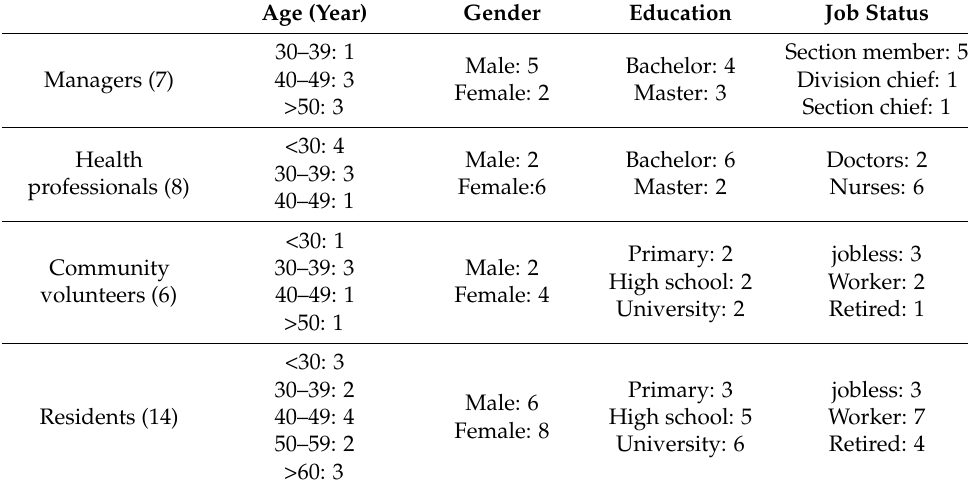
Table 3. Participants’ characteristics.